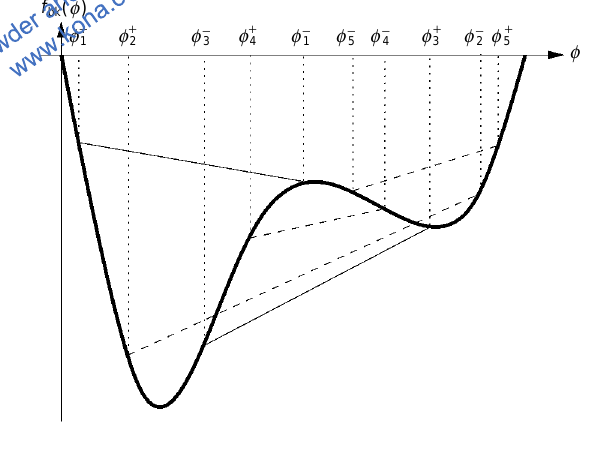
Fig. 5 Geometrical interpretation of Ole˘ınik’s jump entropy con- dition, applied to five jumps between f (cid:3) (cid:2) f i (cid:2) 1, …, 5. For i (cid:2) 1, 3 the condition is satisfied (solid chords), for i (cid:2) 2, 4, 5 it is violated (dashed